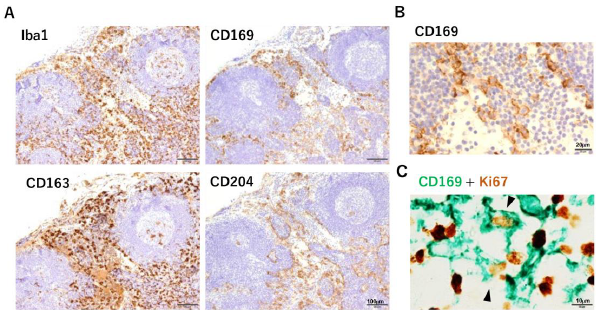
Figure 2. Immunohistochemical analysis of human lymph nodes. ( A ) SMs were positive for CD169, CD163, and CD204. Lymphatic endothelial cells were also positive for CD204. Scale bar, 100 µm. ( B ) High-power field examination of the lymph sinus. The cell membrane of macrophages was positive for CD169. Scale bar, 20 µm. ( C ) Double immunohistochemical staining of CD169 (green) and Ki67 (brown) in the lymph node sinus. Some double-positive cells were observed. Scale bar, 10 µm. Table 1. Clinical significance of CD169 + sinus macrophages (SMs) in solid tumors.